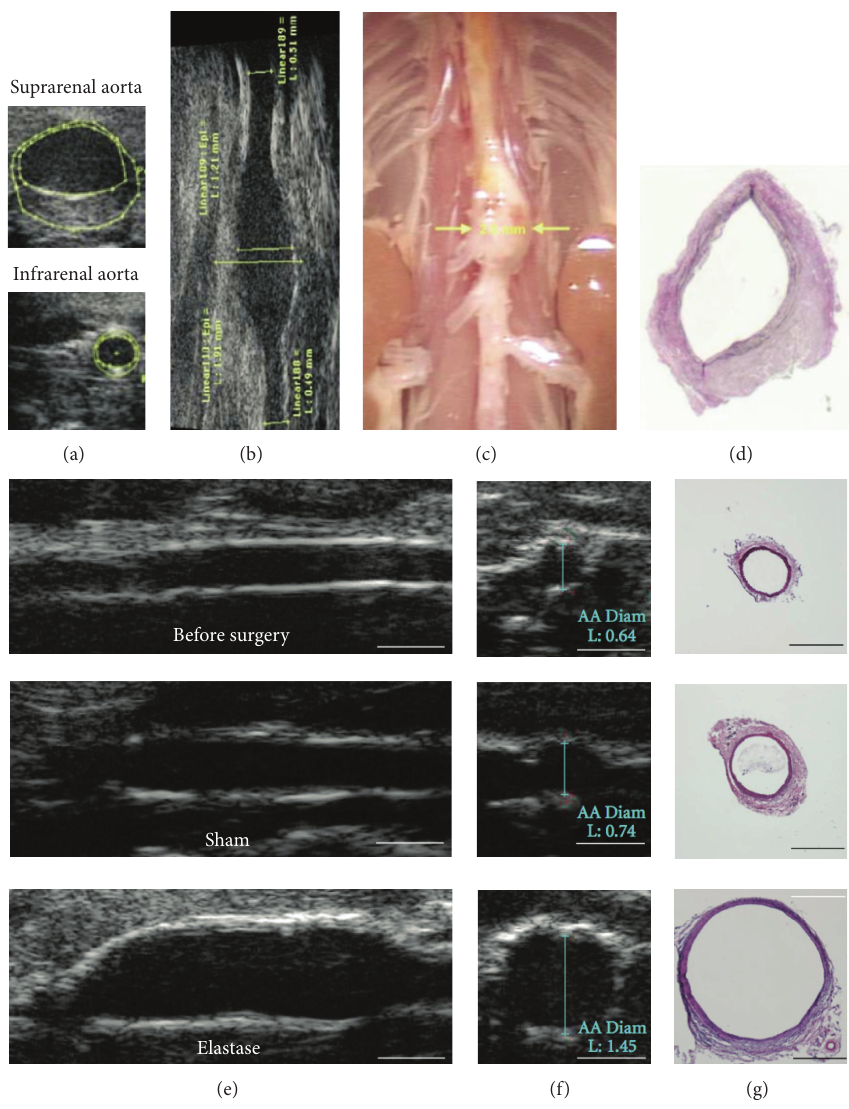
Figure 1: Example of high-frequency anatomical ultrasound images of abdominal aortas obtained noninvasively. ((a)–(d)) Images of a suprarenal angiotensin II-induced abdominal aortic aneurysm (AAA). (a) Transverse ultrasound images of suprarenal and corresponding infrarenal aorta. (b) Longitudinal view of a suprarenal AAA. (c) Dissected abdominal aorta for anatomical comparison and (d) histological cross-section of the suprarenal aorta from the same animal in the dilated region. ((e)–(g)) Images of elastase-induced AAAs. (e) Longitudinal images of the vessel before surgery, after sham surgery, and after intraluminal elastase perfusion. (f) Corresponding transverse images and (g) histological cross-sections stained with H & E. Figure adapted from [45] for ((a)–(d)) and [46] for